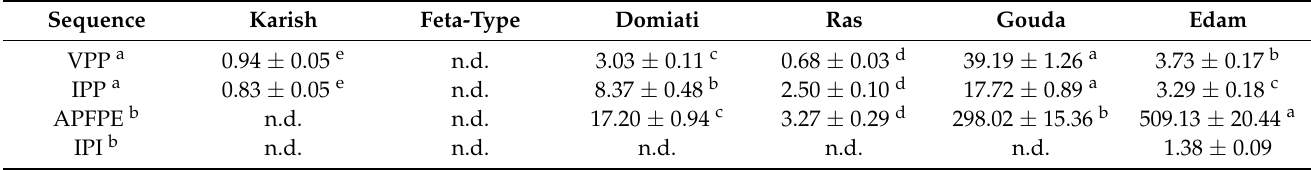
Table 4. The amounts of bioactive peptides in the low-molecular weight peptide fractions of the analysed cheeses. The results are reported as mg/100 g of